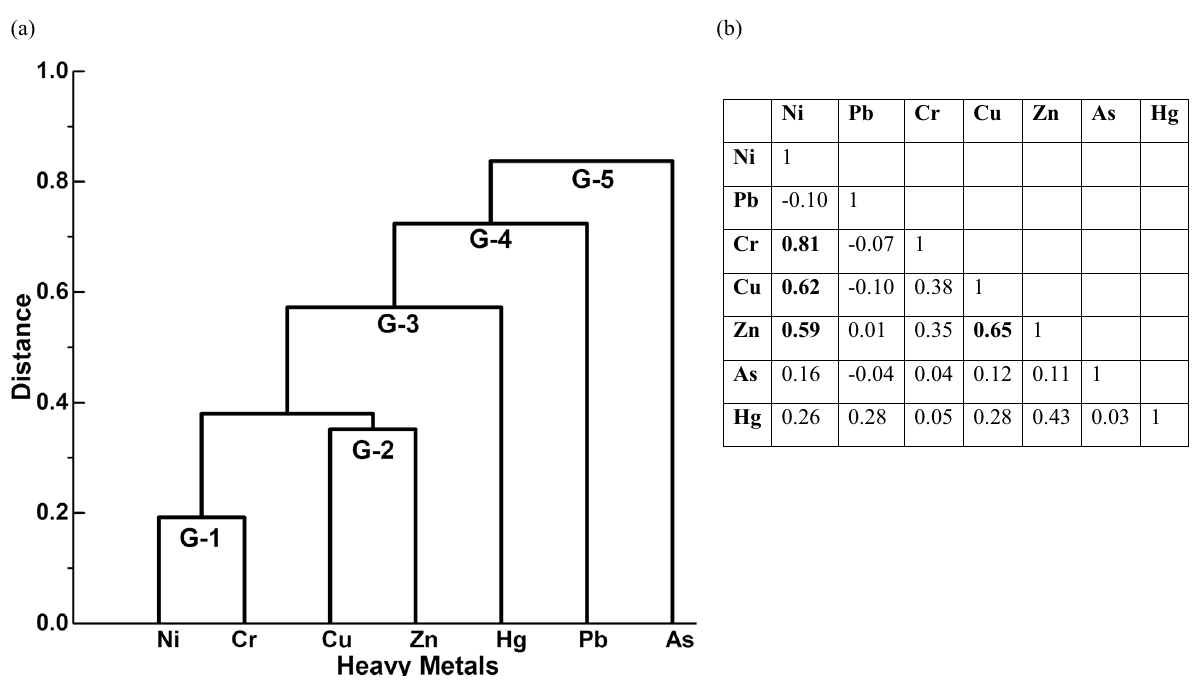
Figure 7. ( a ) Hierarchical cluster analysis and ( b ) Pearson’s correlation matrix of selected heavy metals in the surface sediment samples used in this study, bold values indicate strong correlation of metals with each